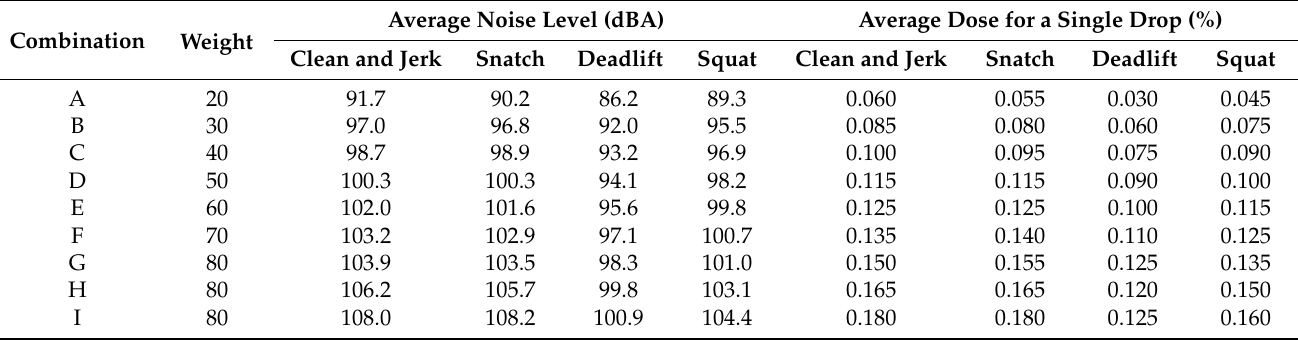
Table 3. Representative data of noise and dose